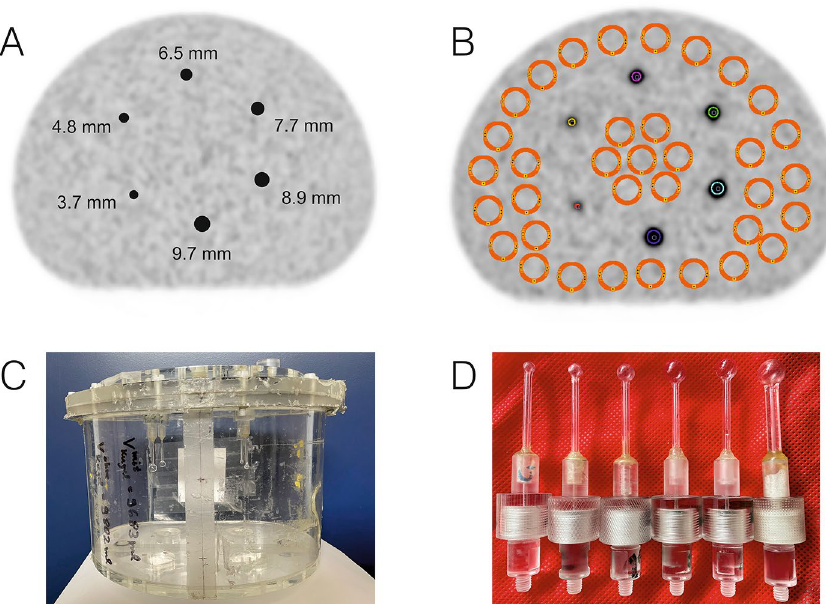
Figure 1. (A) Schematic representation of the small tumour phantom with small spherical inserts (sphere diameters are indicated). (B) Positions of the background ROIs (orange) and sphere VOIs (multiple colours). (C) Pictures of the small tumour phantom and (D) pictures of the spherical inserts.